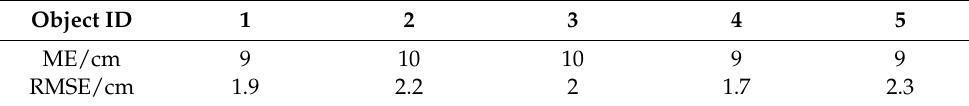
Table 6. Elevation errors of the moving objects. Table 4. The experimental time statistics in CPU and GPU hardware environments, respectively.